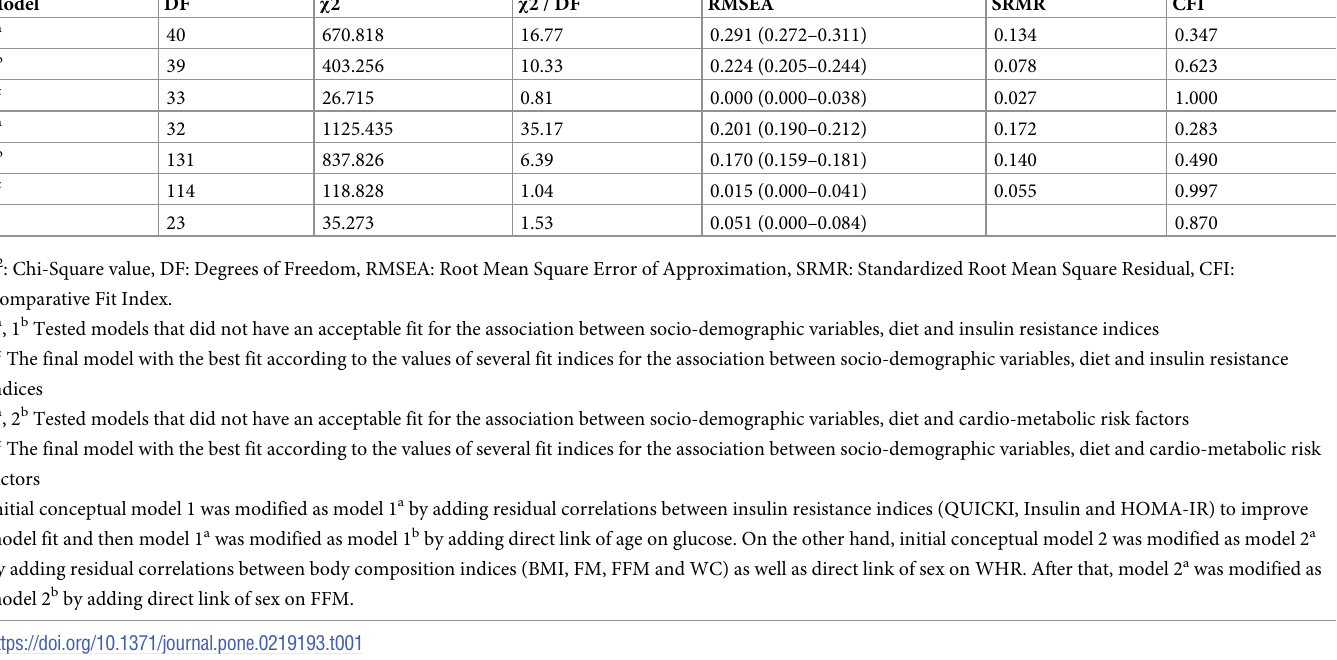
Table 1. Goodness of fit indices for models.